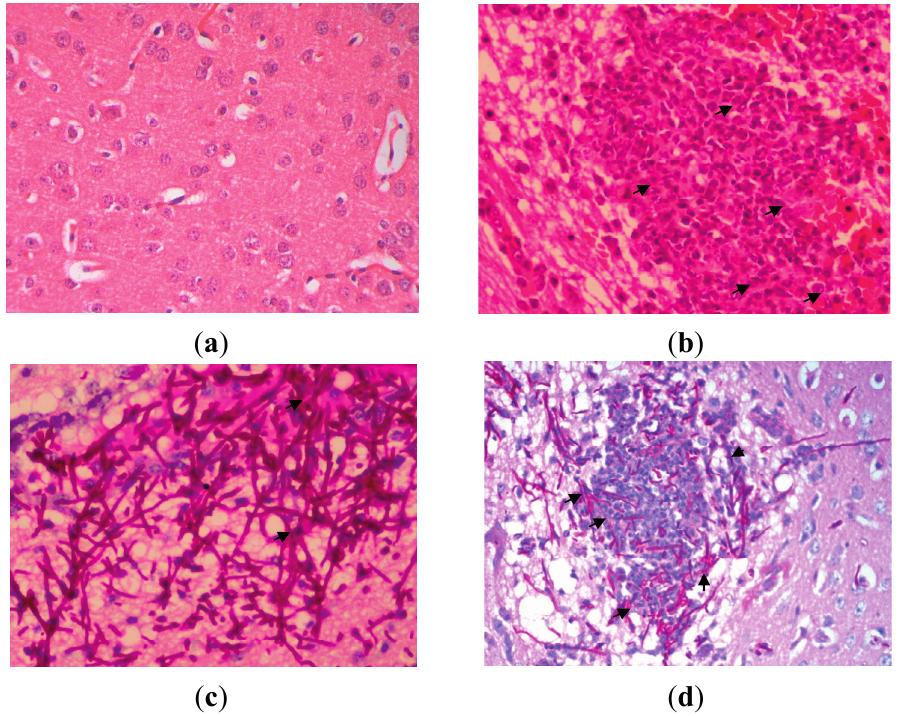
Figure 5. Brain tissues on 72 h post-infection with C. albicans , ( a ) uninfected brain; H&E stain; original magnification, ×400 (Tissues were normal, no inflammation, haemorrhage and infiltration of polymorphonuclear cells were observed) ( b ) H&E stain; original magnification, ×400 (Arrows indicate a large polymorphonuclear infiltrate is demonstrated in the abscess in the center of the photomicrograph); ( c ) PAS stain; original magnification, ×400 (Arrows indicated hyphae and fungal bodies of C. albicans ); and ( d ) PAS stain; original magnification, ×400 (Arrows indicate hyphae and fungal bodies of C. albicans surrounding the abscess).